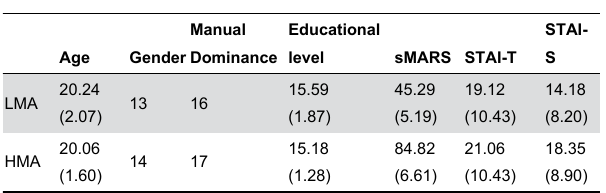
Table 1. Means and standard deviations (in brackets) for age, educational level, math anxiety, trait and state anxiety and frequencies for gender and manual dominance for the LMA and the HMA